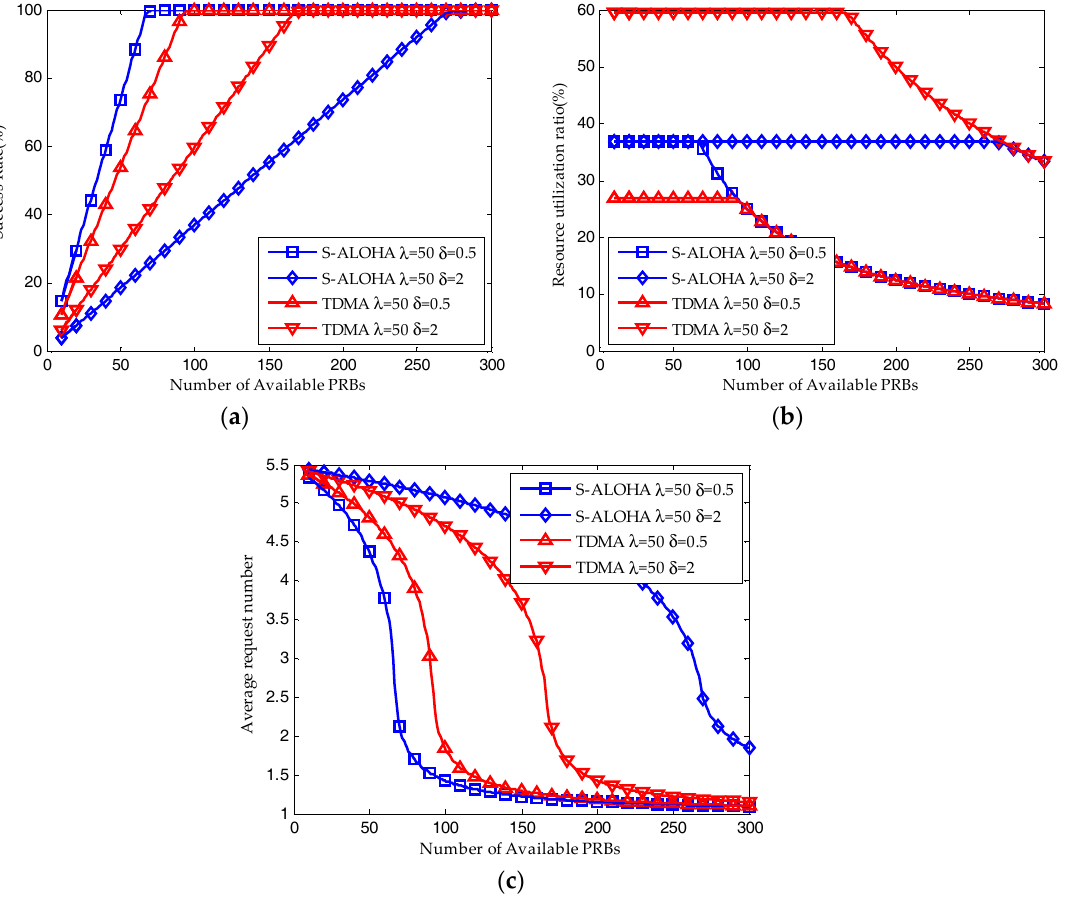
Figure 5. Performance results of pure S-ALOHA protocol and pure TDMA protocol with different packet size (Q = 10, W BO = 0): ( a ) Average success probability; ( b ) Resource utilization ratio; ( c ) Average request number.